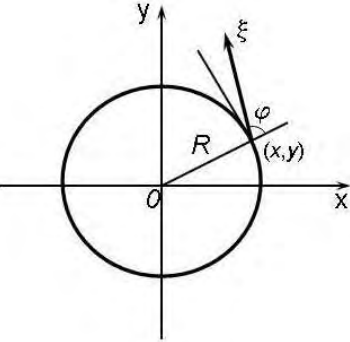
Figure 2. The vector field ξ = ( bx − ay,ax + by ) in Cartesian coordinates ( a = sin ϕ, b = cos ϕ, ϕ = απ/ 2 , | ξ | = R ) .